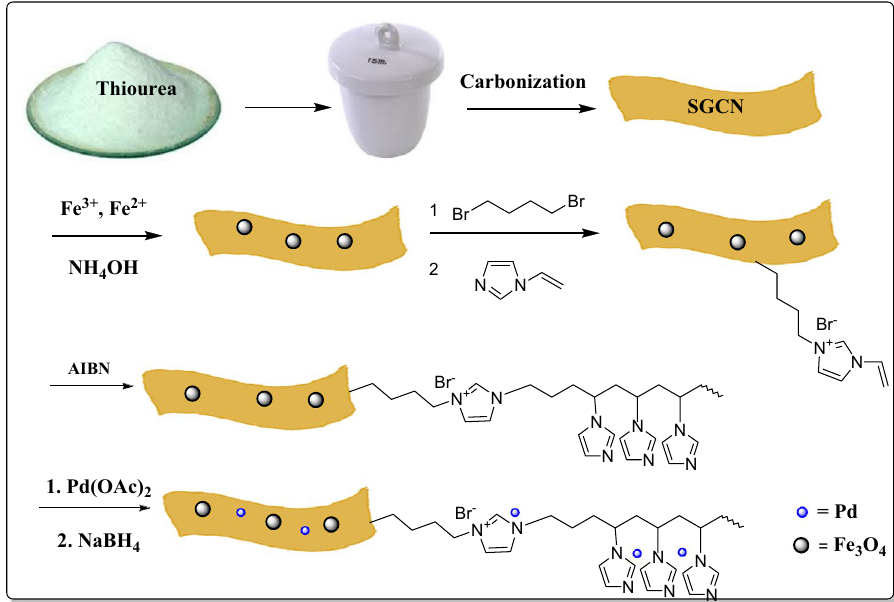
Figure 1. The schematic procedure of the synthesis of the SGCN/Fe 3 O 4 /PVIs/Pd